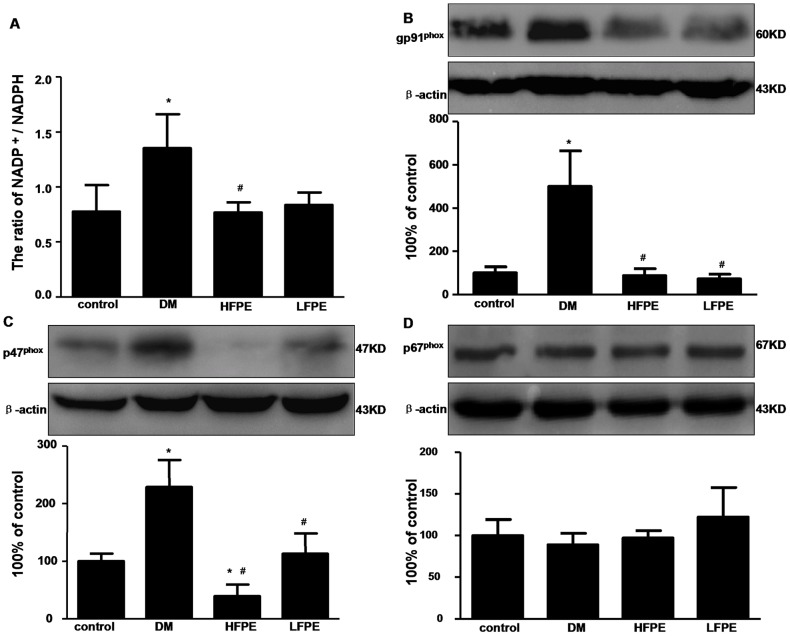
FPE inhibited NADPH oxidase activity and subunits expression in experimental diabetic mice.A: FPE decreased the ratio of NADP+/NADPH in experimental diabetic mice, n = 6 per group. B: western blots analysis of gp91phox, n = 3 per group. C: western blots analysis of p47phox, n = 3 per group. D: western blots analysis of p67phox, n = 3 per group. HFPE: high dose, 200 mg/kg; LFPE: low dose, 100 mg/kg. Data are mean ± SD. *
P<0.05 vs control group; #
P<0.05 vs DM group.